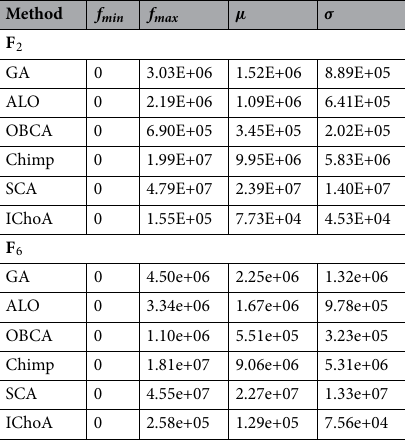
Table 11. Total energy consumption outputs of metaheuristics on F 2 and F 6 .